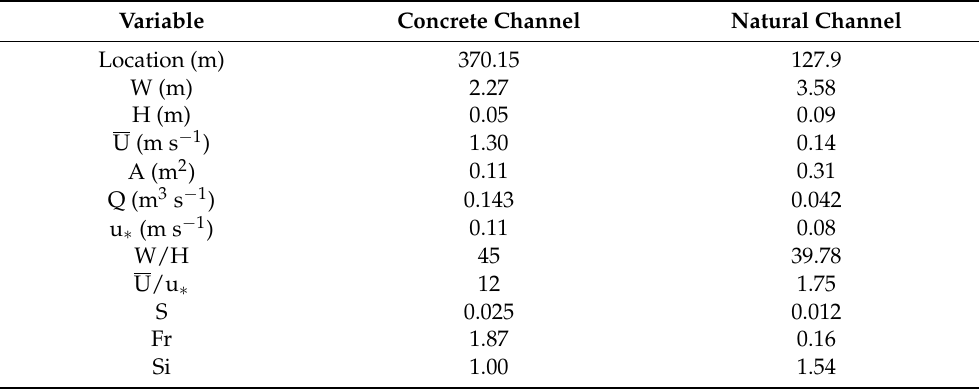
Table 3. Reach-averaged hydraulic characteristics for locations in the equilibrium zone of the two experimental